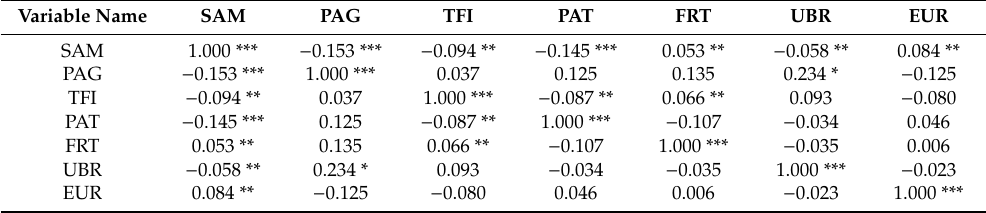
Table 11. The QAP association analysis of influencing factors.